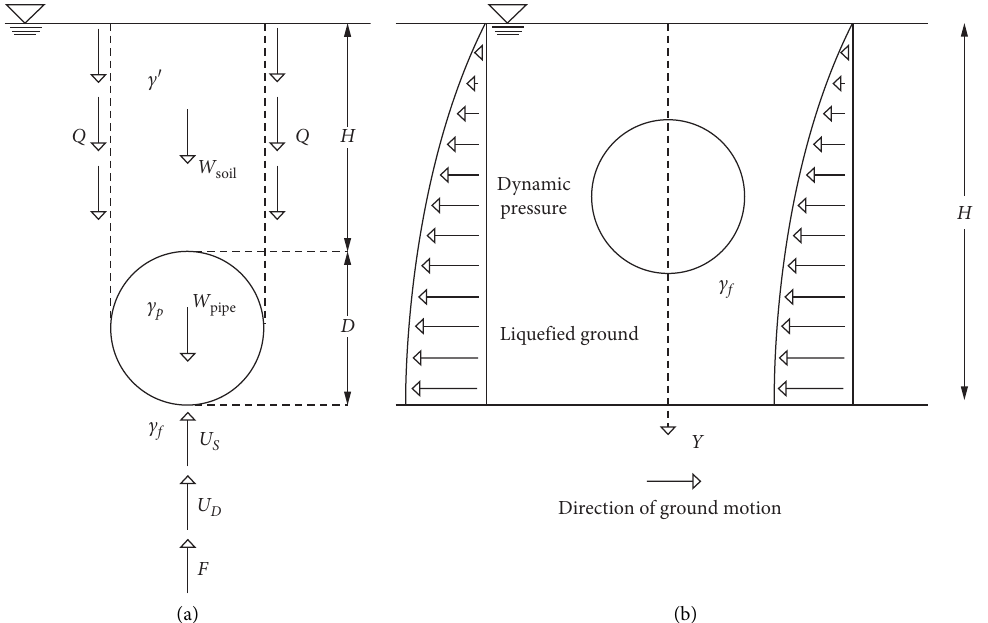
Figure 2: Simplified schemes of vertical equilibrium (a) and horizontal equilibrium